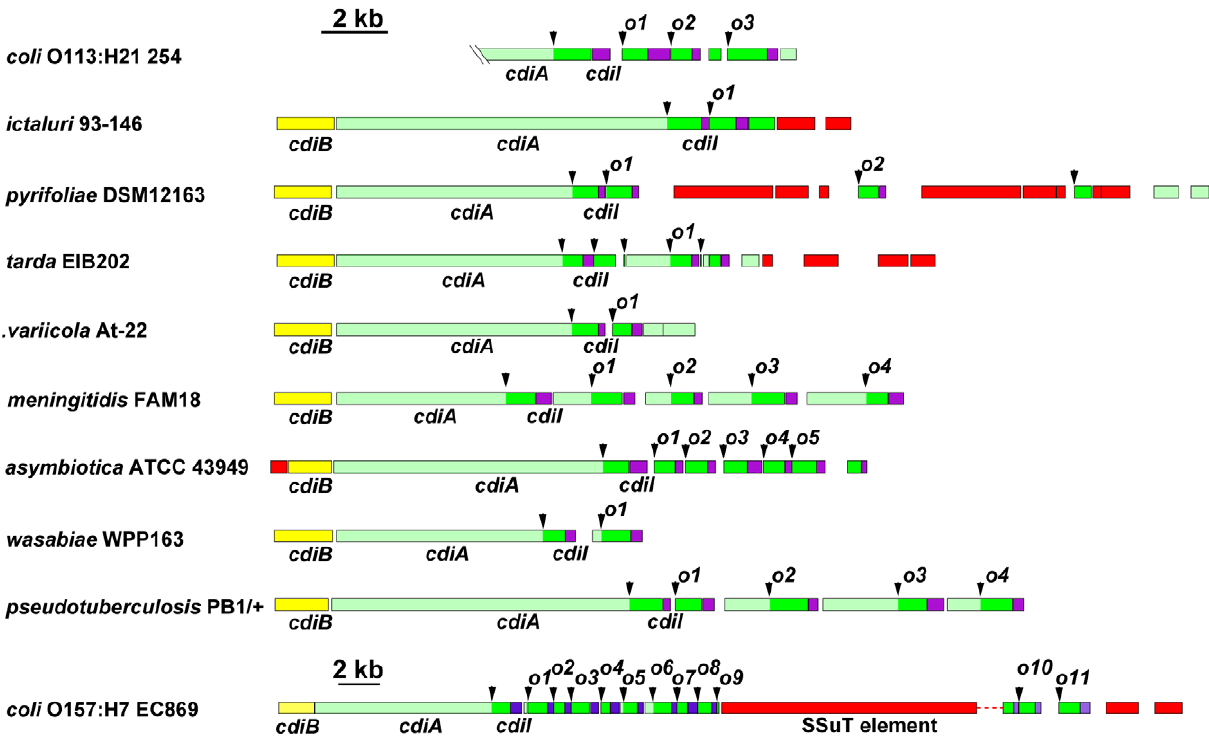
Figure 2. Many bacteria contain orphan cdiA-CT/cdiI modules. The cdi loci from selected bacterial species are presented using the color- coding scheme in Figure 1. Arrowheads indicate the positions of VENN encoding regions. Probable orphan cdiA-CT/cdiI modules are indicated with an ‘‘o’’ and numeral. Note the change in scale for the locus from E. coli EC869. The UniProt accession numbers for the encoded CdiA proteins are: Escherichia coli 254 ser. O113:H21 (A1XT91); Edwardsiella ictaluri 93–146 (C5BAK2); Erwinia pyrifoliae DSM 12163 (D2T668); Edwardsiella tarda EIB202 (D0ZDG0); Klebsiella variicola At-22 (D3RCW8); Neisseria menigitidis FAM18 (A1KSB8); Photorhabdus asymbiotica ATCC 43949 (B6VKN5); Pectobacterium wasabiae WPP163 (D0KFH4); Yersinia pseudotuberculosis PB1/ + (B2K3A8); and Escherichia coli EC869 (B3BM48). The E. coli 254 genomic sequence does not include the 5 9 -end of the cdiA gene.